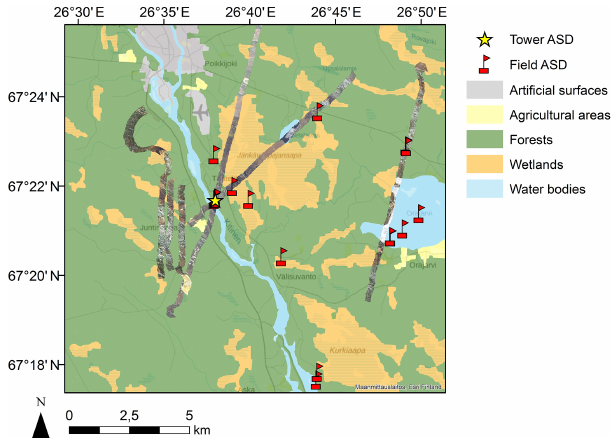
Figure 3. AisaDUAL flight lines measured in 2010 and 2011, and the measurement points of the portable field and the mast- borne measurements at the FMI-ARC main site. The CORINE Land Cover 2018 classification by the Copernicus programme and a basemap is shown in the background (© National Land Survey of Finland, Esri Finland December